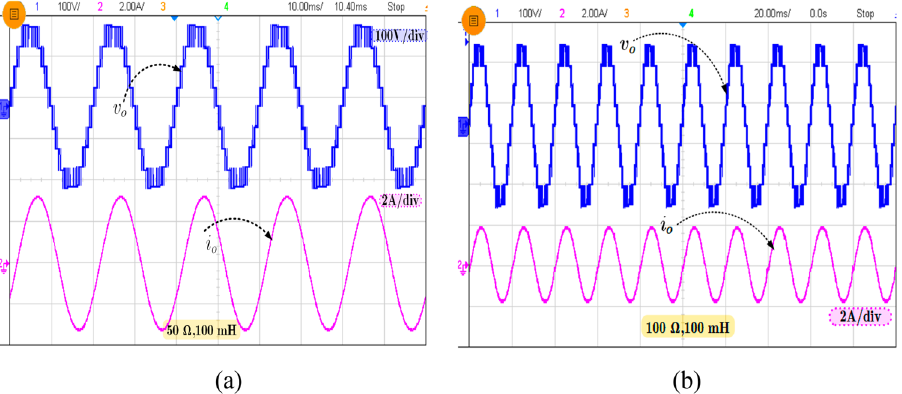
Figure 6. Experimental results showing the output voltage and current waveform for ( a ) R = 50 Ω, L = 50 mH and ( b ) R = 100 Ω, L = 50